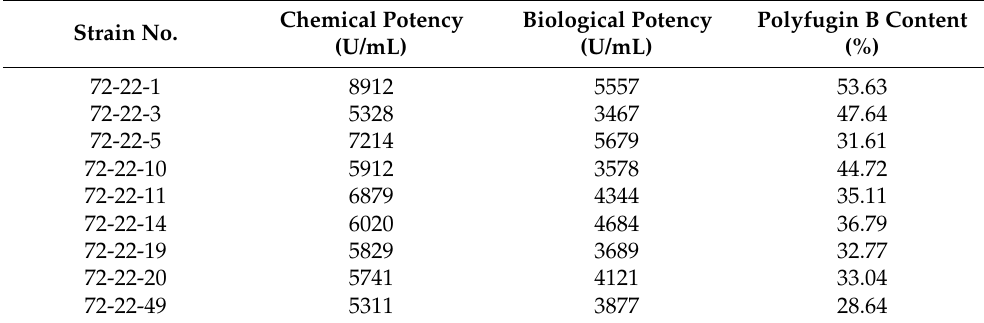
Table 4. Biological potency and Polyfungin B contents of various strains after the second round of UV mutagenesis.